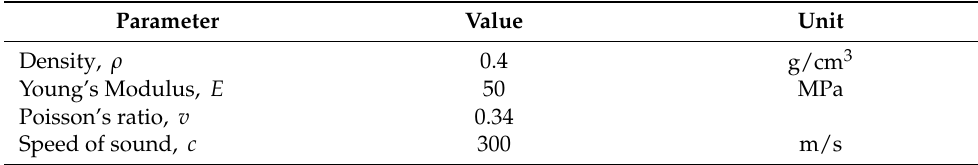
Table 4. Specifications of silica aerogel layer [21].